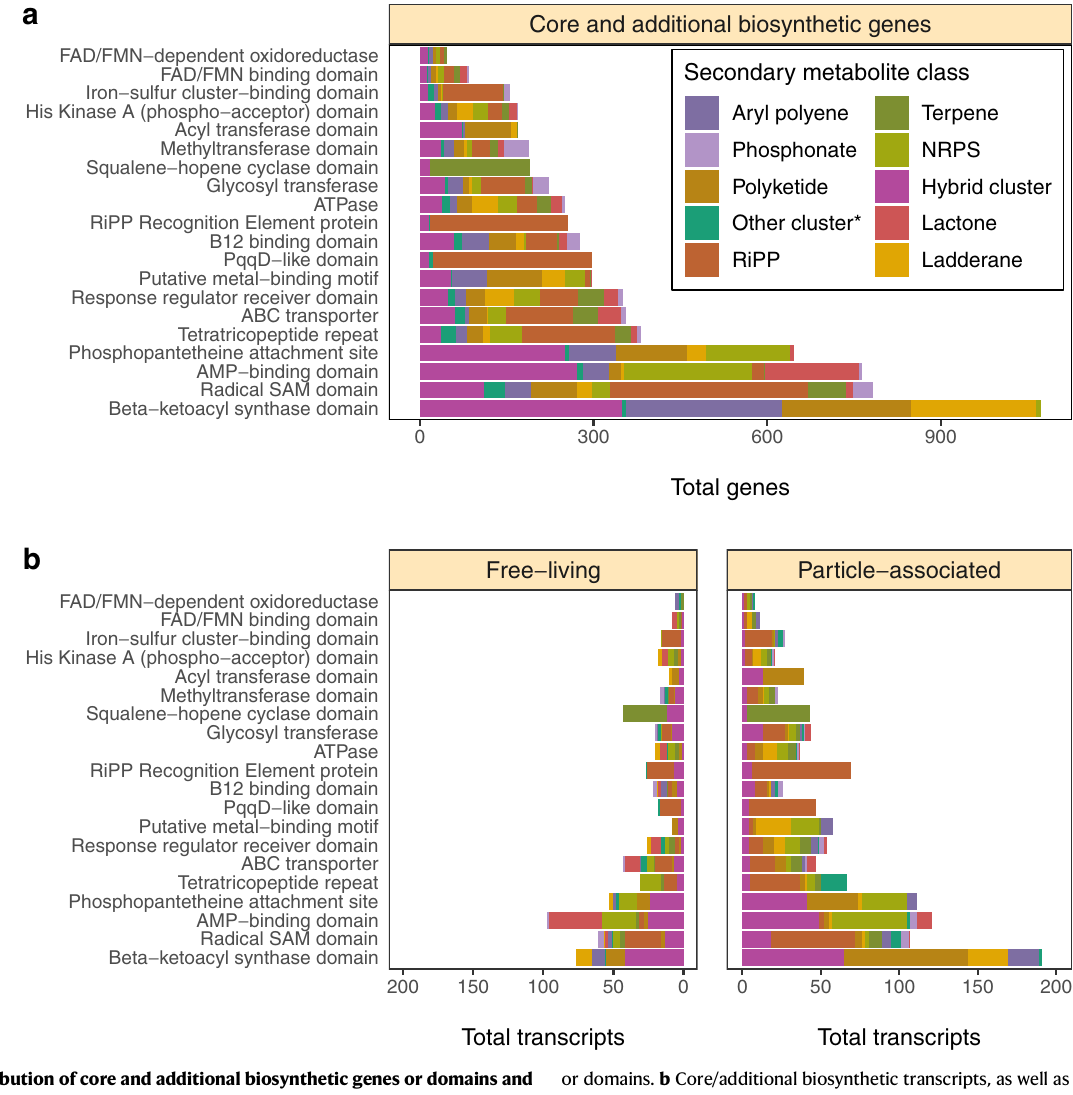
or domains. b Core/additional biosynthetic transcripts, as well as transcripts encoding tailoring enzymes and biosynthetically important protein domains dif- ferentially expressed or solely expressed in the free-living (left-hand panel) and particle-associated (right-hand panel) metatranscriptomes; colored by BGC pro- duct class. Source data are provided as a Source Data fi